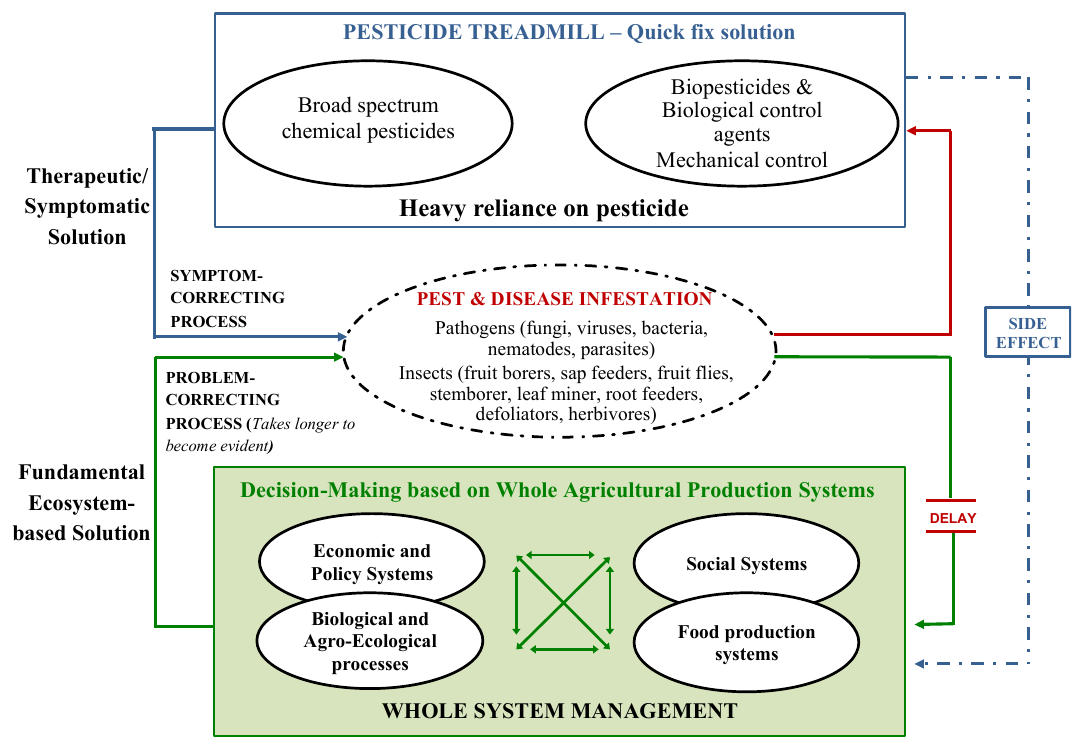
Figure 2. The figure displays a system thinking approach in which the study of the whole crop system is placed before that of the components such as pest or disease. The approach links all system components to provide a comprehensive assessment of crop production within the ecosystem with emphasis on multitrophic interactions including delays and side effect taking into account socio-economical and socio-ecological challenges. Figure was adapted with permission from H. Tonnang [121].